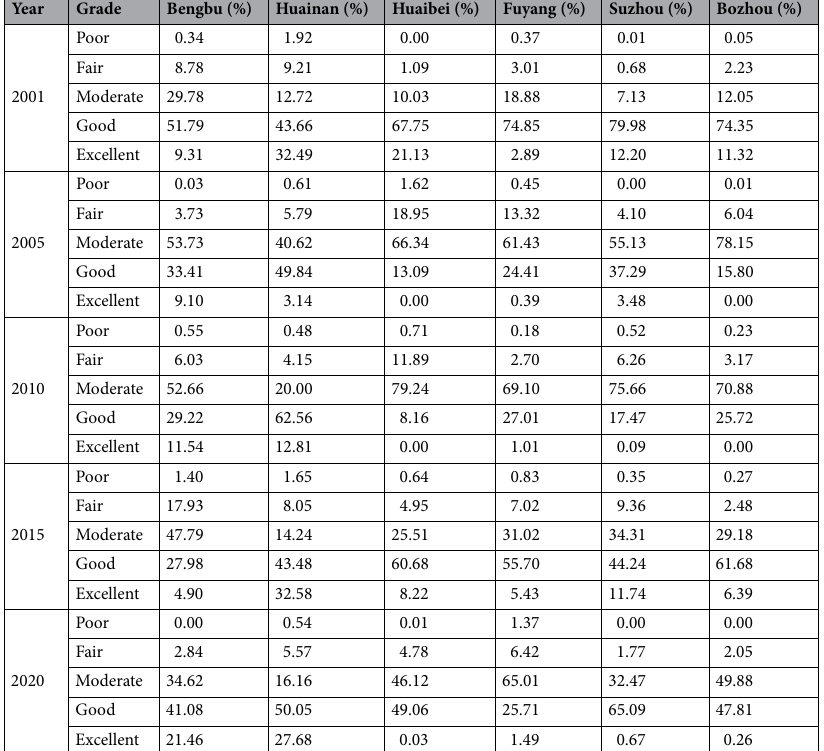
Table 5. Statistics on the proportion of RSEI grades of cities in northern Anhui from 2001 to